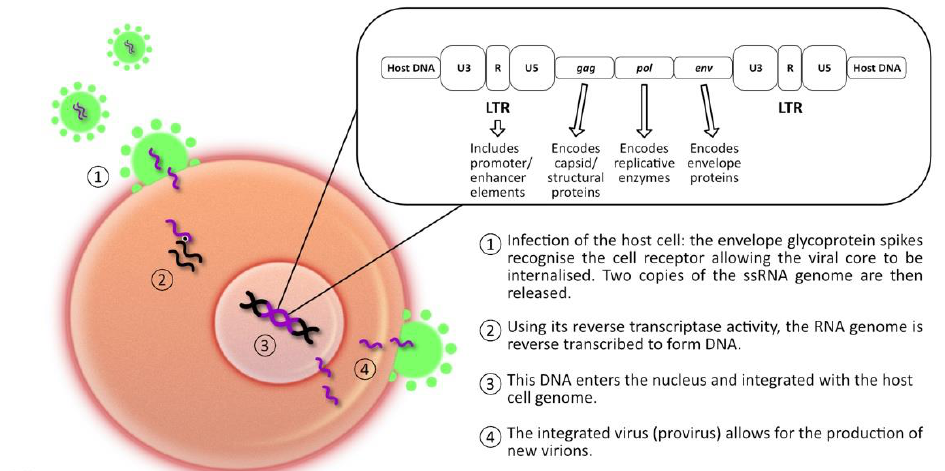
Figure 1. Schematic representation of FeLV integration within a host cell. The viral genome is depicted at the top of this image. The three genes ( gag , pol , and env ) within this simple retrovirus are flanked by long terminal repeats (LTRs) comprised of U3, R, and US regions. FeLV serves as an example of retroviral integration into the host DNA, with similar mechanisms employed by both FIV and MMTV.